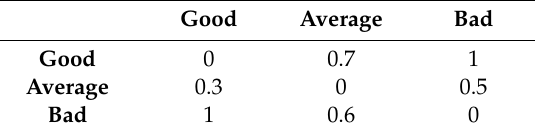
Table 6. Comparison criterion for feature